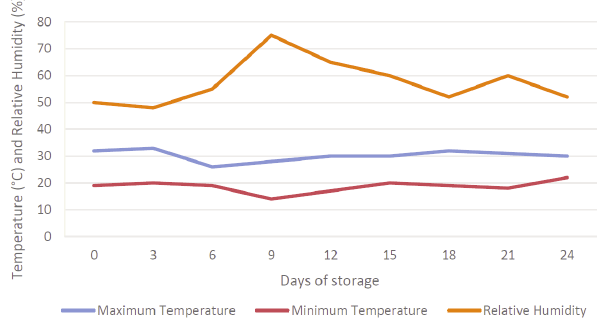
Fig. 1 ­ Graphical representation of temperature and relative humidity during storage period of